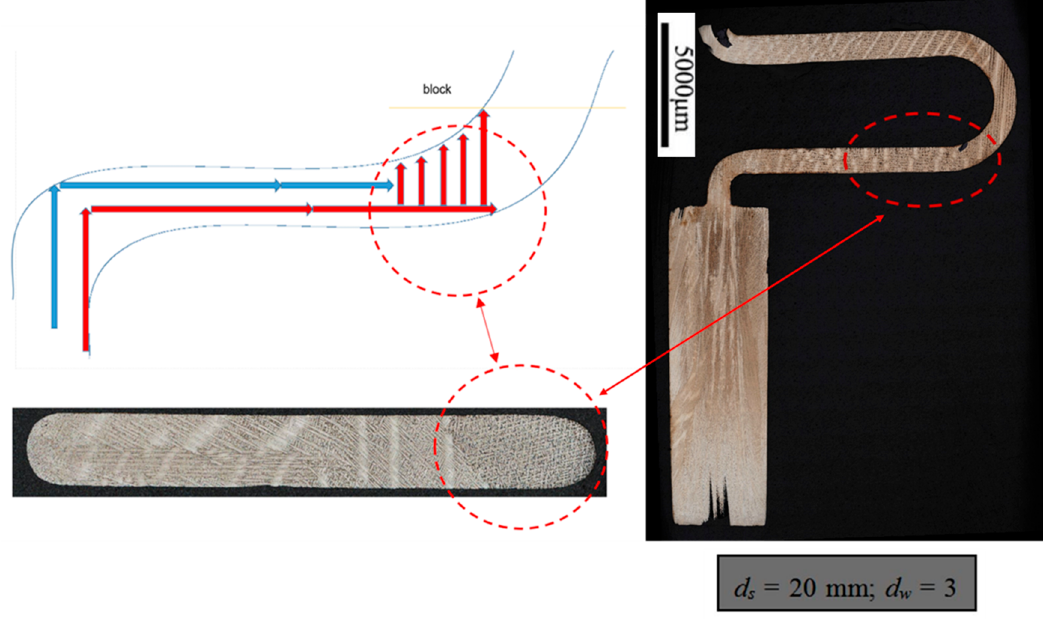
Figure 6. Schematic of the grain competitive and block mechanism with a long pitch length.